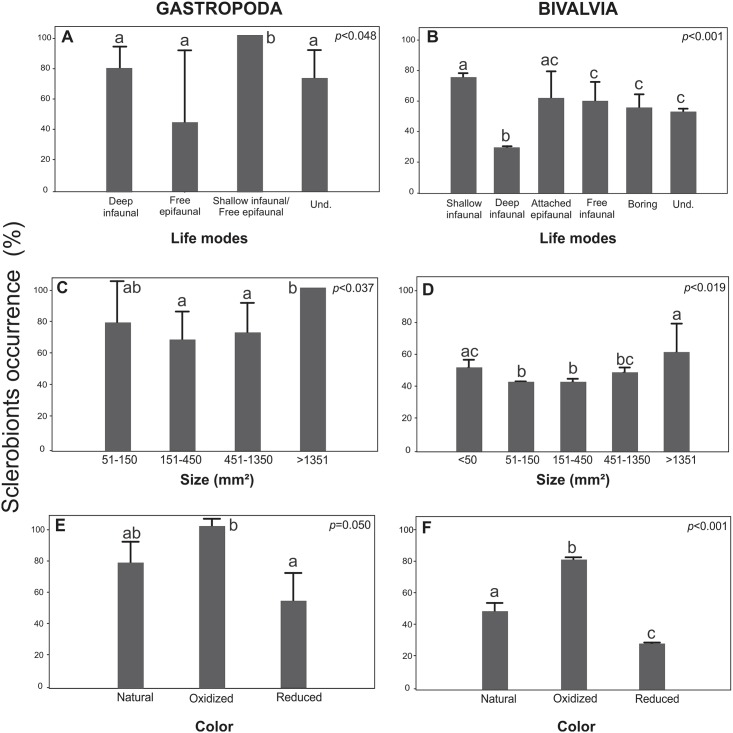
The occurrence of sclerobionts exposed to distinct life modes, sizes, and colors of the host substrates.(A) Gastropod life modes. (B) Bivalvia life modes. (C) Gastropod sizes (D) Bivalvia sizes. (E) Gastropod color. (F) Bivalvia color. Und.: Unidentifiable. The vertical lines denote the 95% confidence intervals (standard error*1.96), and the lowercase letters indicate similarities (the same letters) or significant differences (different letters) between the factors evaluated (Tukey test).